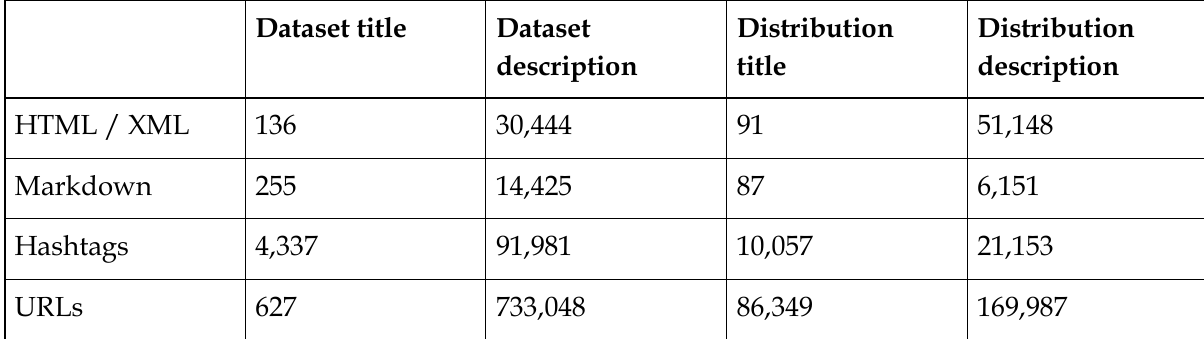
Table 4: Number of text snippets which contain different special character